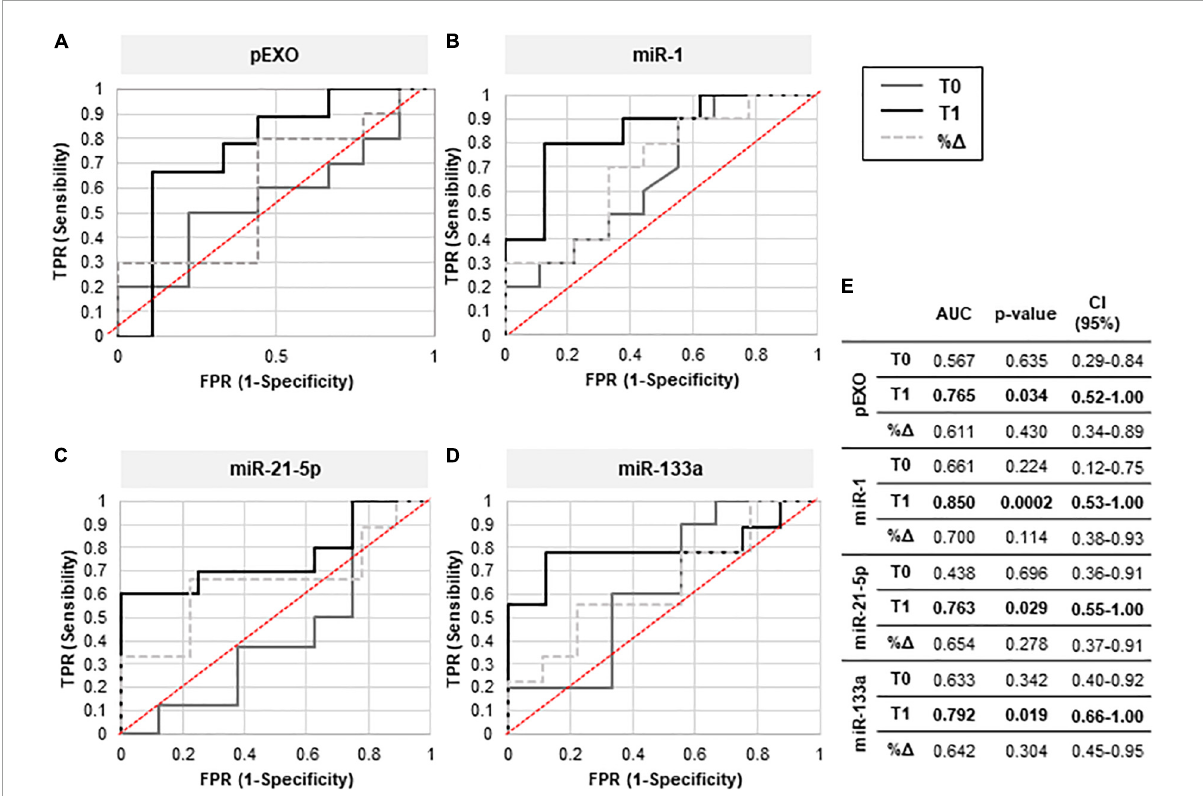
FIGURE5 Diagnostic efficacy of pEXOs levels and exosomal miR-1, miR-21-5p, and miR-133a. The pEXOs were isolated from plasma of MR patients ( n = 19) collected before (T0) and 6 months after MVR surgery (T1). (A) Isolated pEXOs were quantified by NTA as described in the methods. (B–D) Exosomal miRNA-1 (B) , miRNA-21-5p (C) and miRNA-133a (D) were quantified through qRT-PCR as described in the method. Patients were divided into HiR-REM and LoR-REM groups. The diagnostic efficiency of T0, T1, and % (cid:49) levels of pEXOs (particles/uL) (A) and of the microRNAs miR-1 (B) , miR-21-5p (C) and miR-133a (D) (2 − (cid:49)(cid:49) CT ) in distinguishing patients with Low and High postoperative reverse LV remodeling was evaluated by the receiver operating characteristic (ROC) curve analysis as described in the methods. The AUC